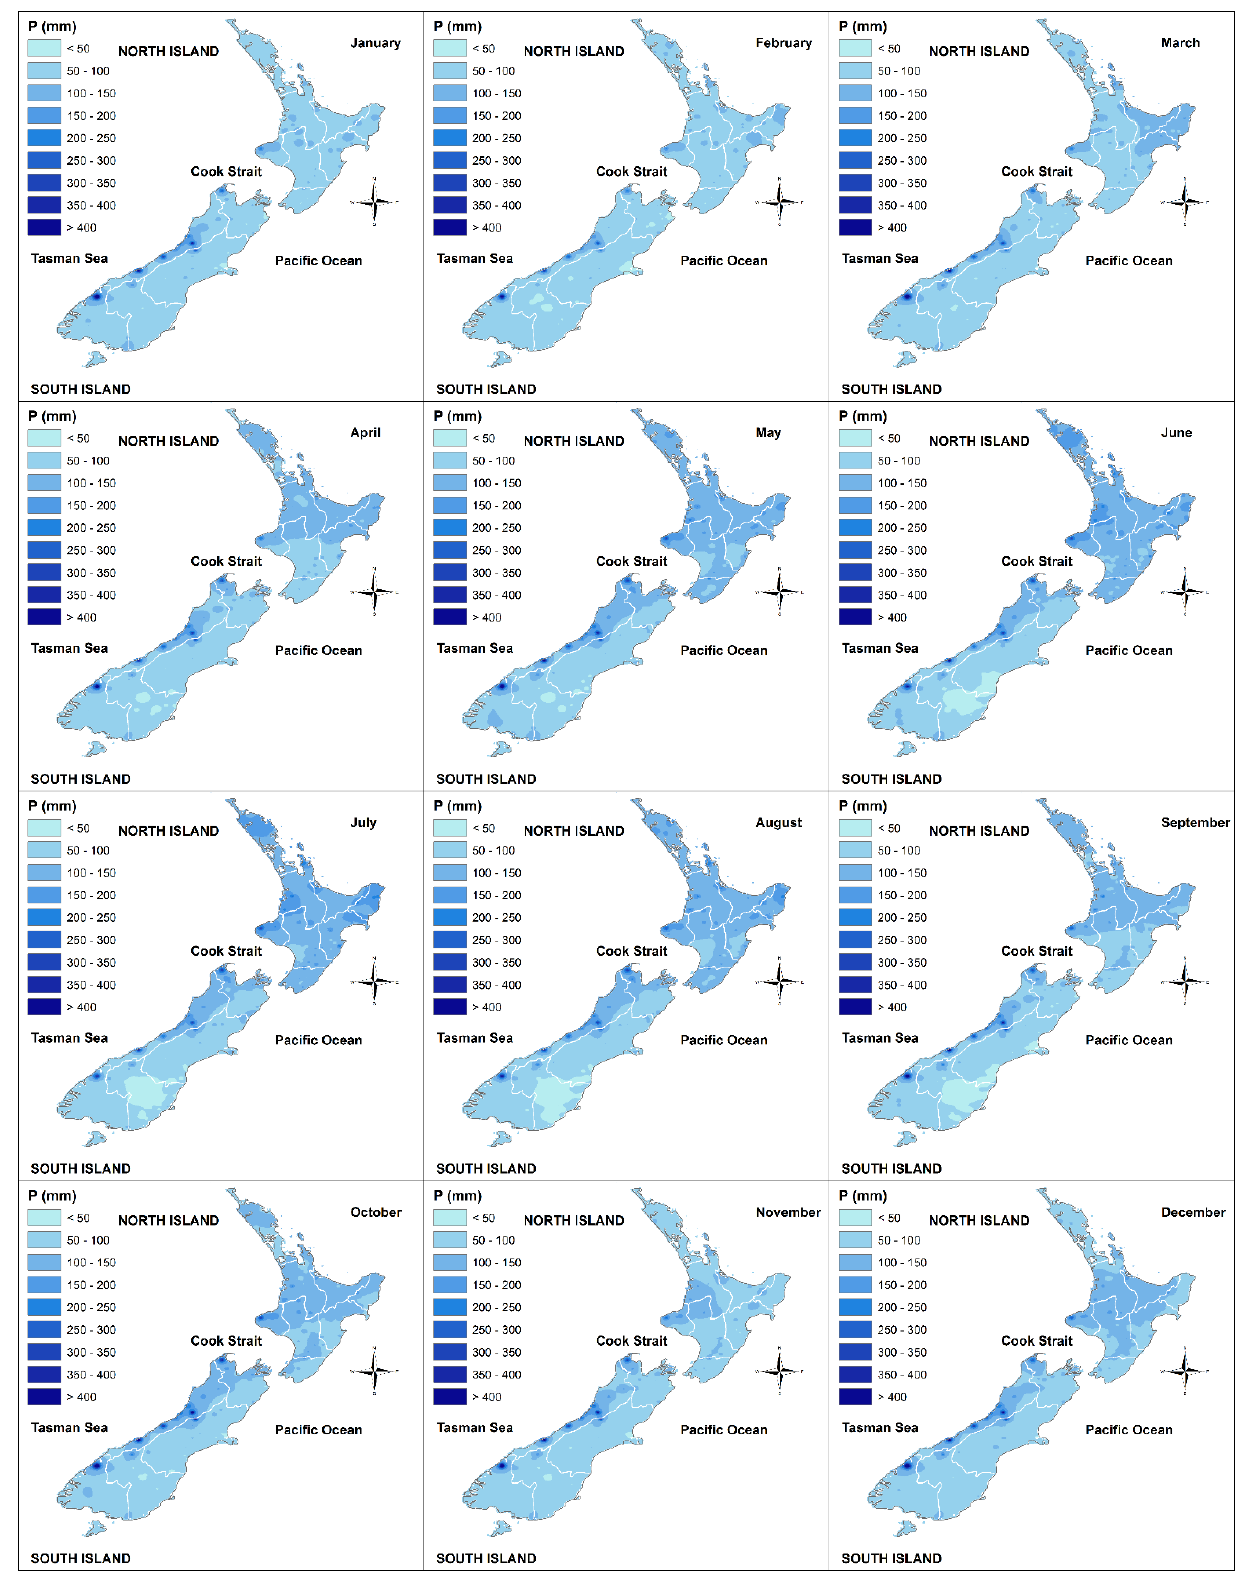
Figure 3. Mean monthly precipitation interpolated using inverse distance weighting (IDW) method.